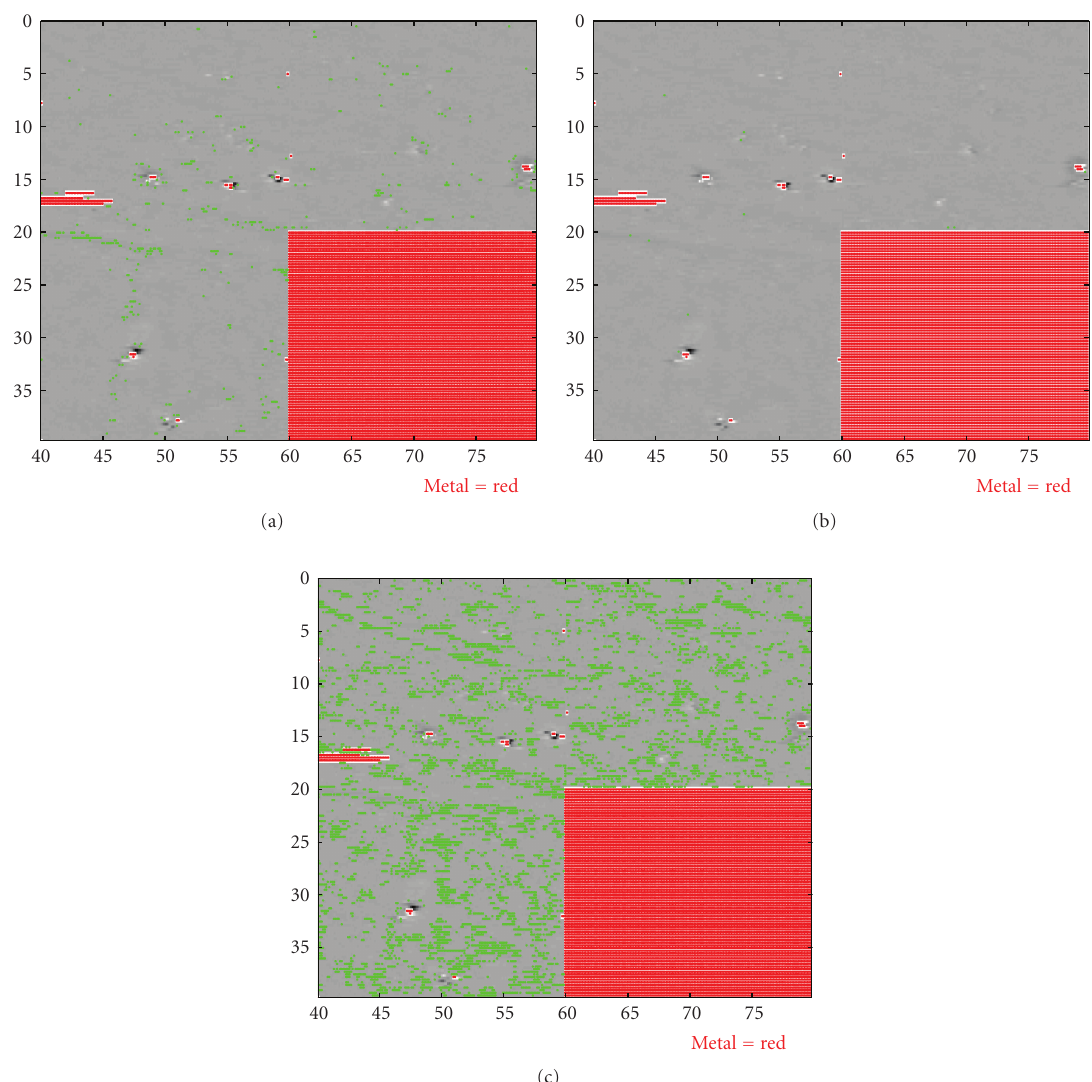
Figure 12: Representative results of various membership function values: (a) A = 0 . 75, B = 3, C = − 4. These values were used in the study because they provide a good balance of eliminating outliers and high cluster compactness; (b) A = 0 . 25, B = 1, C = − 6. These values were not used because of low, noncompact clusters (lowering individual A , B , or C values gave similar results); (c) A = 1 . 25, B = 5, C = − 2. These values were not used because too many points remained (raising individual A , B , or C values gave similar